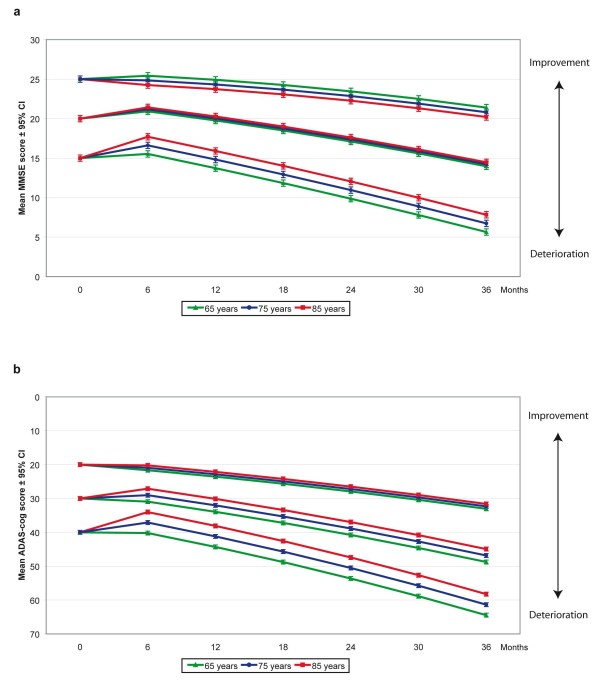
Cognitive outcome and age. a) MMSE, prediction of outcome for different baseline scores and ages. Three-year mean outcomes with 95% confidence intervals predicted by the mixed models for patients with different Mini-Mental State Examination (MMSE) baseline scores (15, 20, and 25) and ages (65, 75, and 85 years), used as arbitrary examples. Older subjects with a baseline MMSE score < 22 exhibited a better six-month treatment response compared with younger patients (P < 0.001). In addition, the interaction MMSE score × Age at the start of ChEI treatment showed a more pronounced age difference at lower baseline scores (P < 0.001). The calculated outcomes were based on a male patient who did not receive NSAID/acetylsalicylic acid treatment, had nine years of education, exhibited an IADL baseline score of 16, and received 65% of the maximum recommended dose of ChEI. b) ADAS-cog, prediction of outcome for different baseline scores and ages. Three-year mean outcomes with 95% confidence intervals predicted by the models for patients with different Alzheimer's Disease Assessment Scale-cognitive subscale (ADAS-cog) baseline scores (20, 30, and 40) and ages (65, 75, and 85 years), used as arbitrary examples. Older individuals exhibited a better response to treatment compared with younger subjects (P = 0.043). The interaction ADAS-cog score × Age at the start of treatment showed a greater age difference at lower baseline levels (P < 0.001). The calculated outcomes were based on a male patient who was an APOE ε4 carrier, did not receive NSAID/acetylsalicylic acid treatment, had nine years of education, exhibited an IADL baseline score of 16, and received 65% of the maximum recommended dose of ChEI.